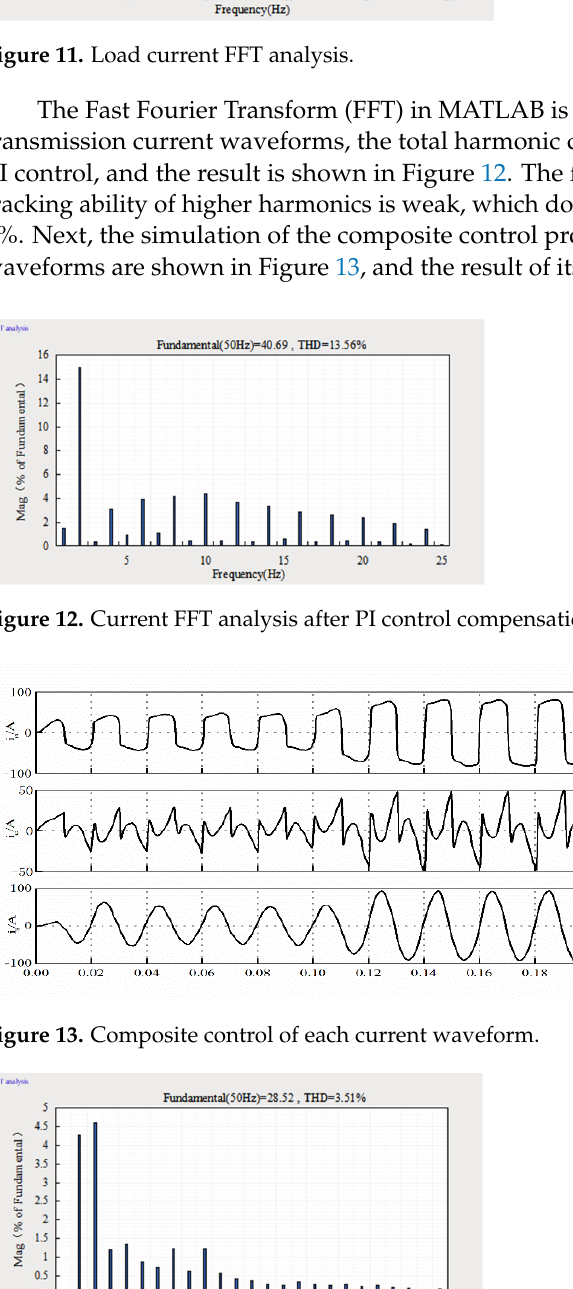
Figure 11. Load current FFT analysis.